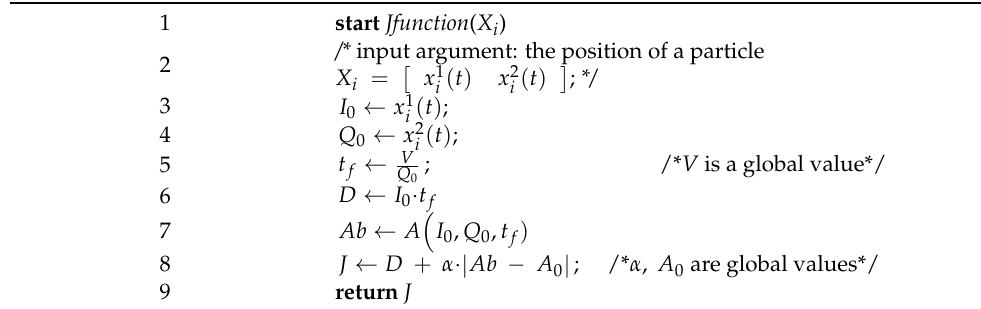
Table 3. Description of the objective